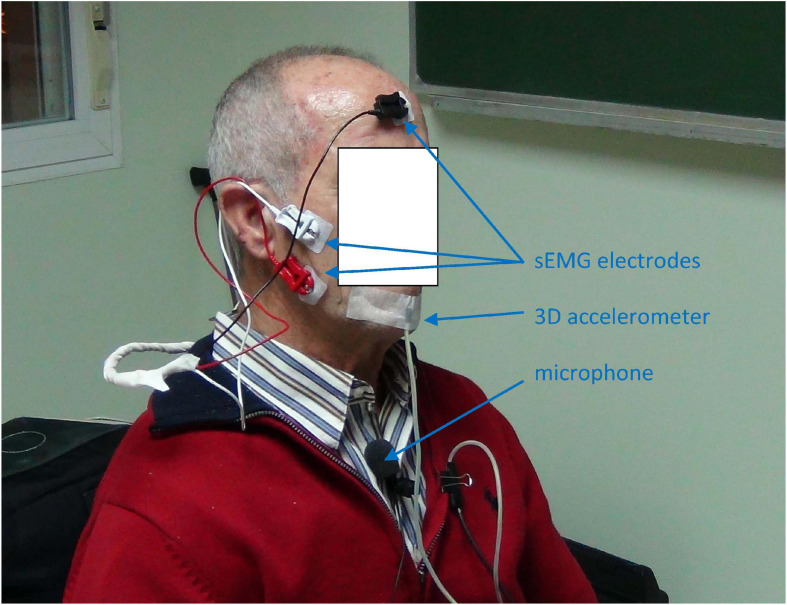
Data recording from a normative male participant: a) the sEMG on the masseter muscle is taken by white and red contact electrodes on the masseter and a reference electrode (black) on the forefront; b) the 3D acceleration is acquired by a 3D accelerometer attached to the chin; the speech signal by a clip wireless cardioid microphone on the chest at 25 cm from the mouth. Jaw-fixed accelerometers are to be used only during signal recording to establish and validate a hands-off acoustic to kinematic projection model, to ultimate use only acoustic signals for at-home monitoring, producing indirect estimations of the neuromotor kinematic characteristics of the participant using the projection model resulting from the study. The participant consented the publication of this anonymized picture.